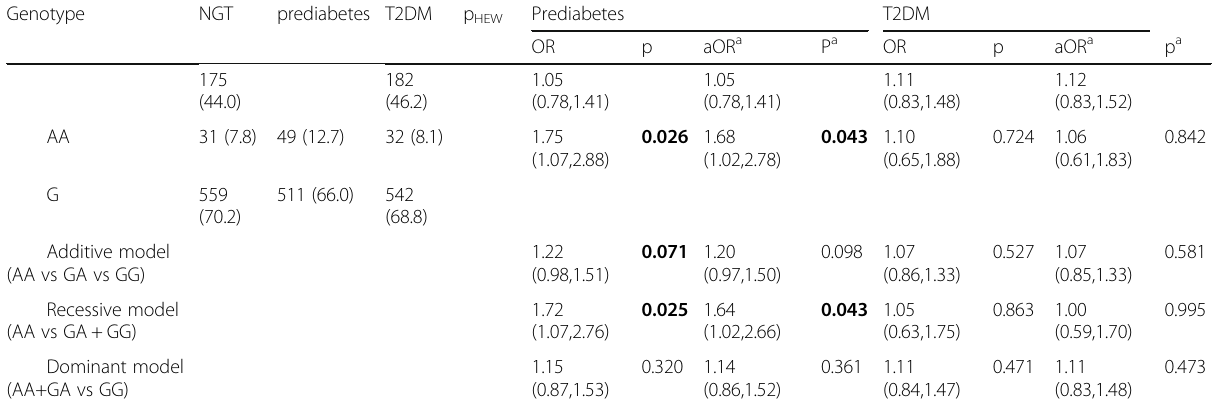
Table 2 Potential prediabetes or T2DM-associated UCP2 and UCP3 polymorphisms (Continued) Genotype NGT prediabetes T2DM p HEW